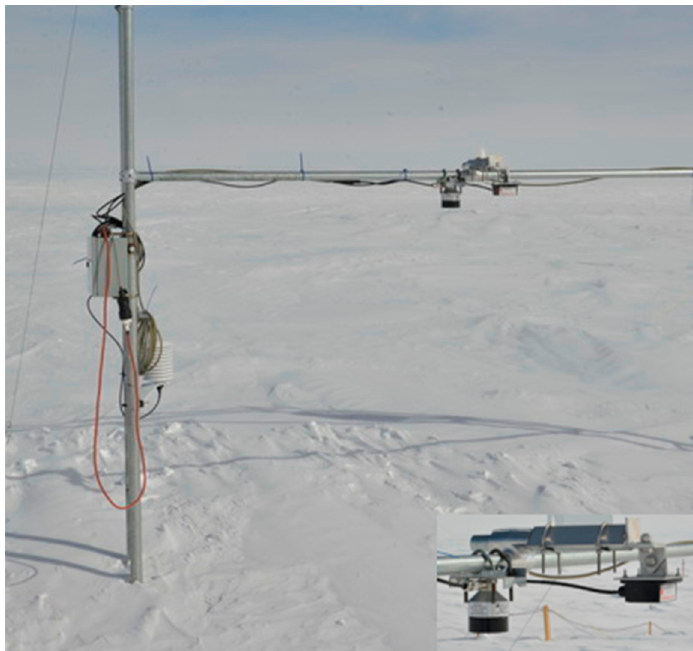
Figure 14. Set-up of the installation at Dome C, Antarctica. The horizontal mast was at 1.5 m above the snow. The close-up shows the ultrasonic snow depth sensor on the left, and the FMCW radar on the